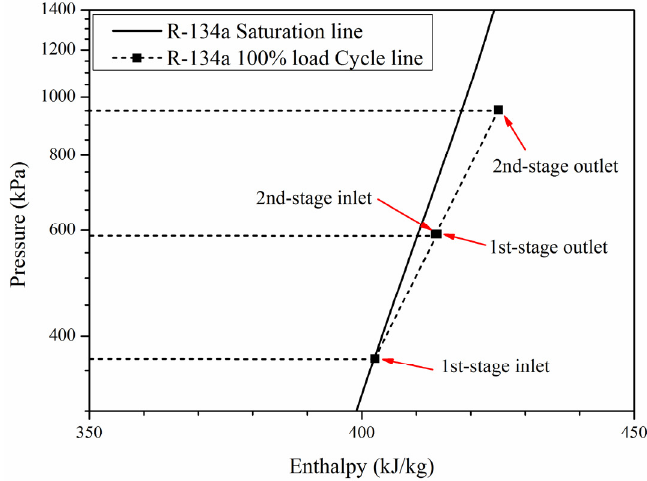
Figure 5. Pressure-enthalpy diagram with the theoretical operational cycle of the R-134a centrifugal compressor at 100% load.